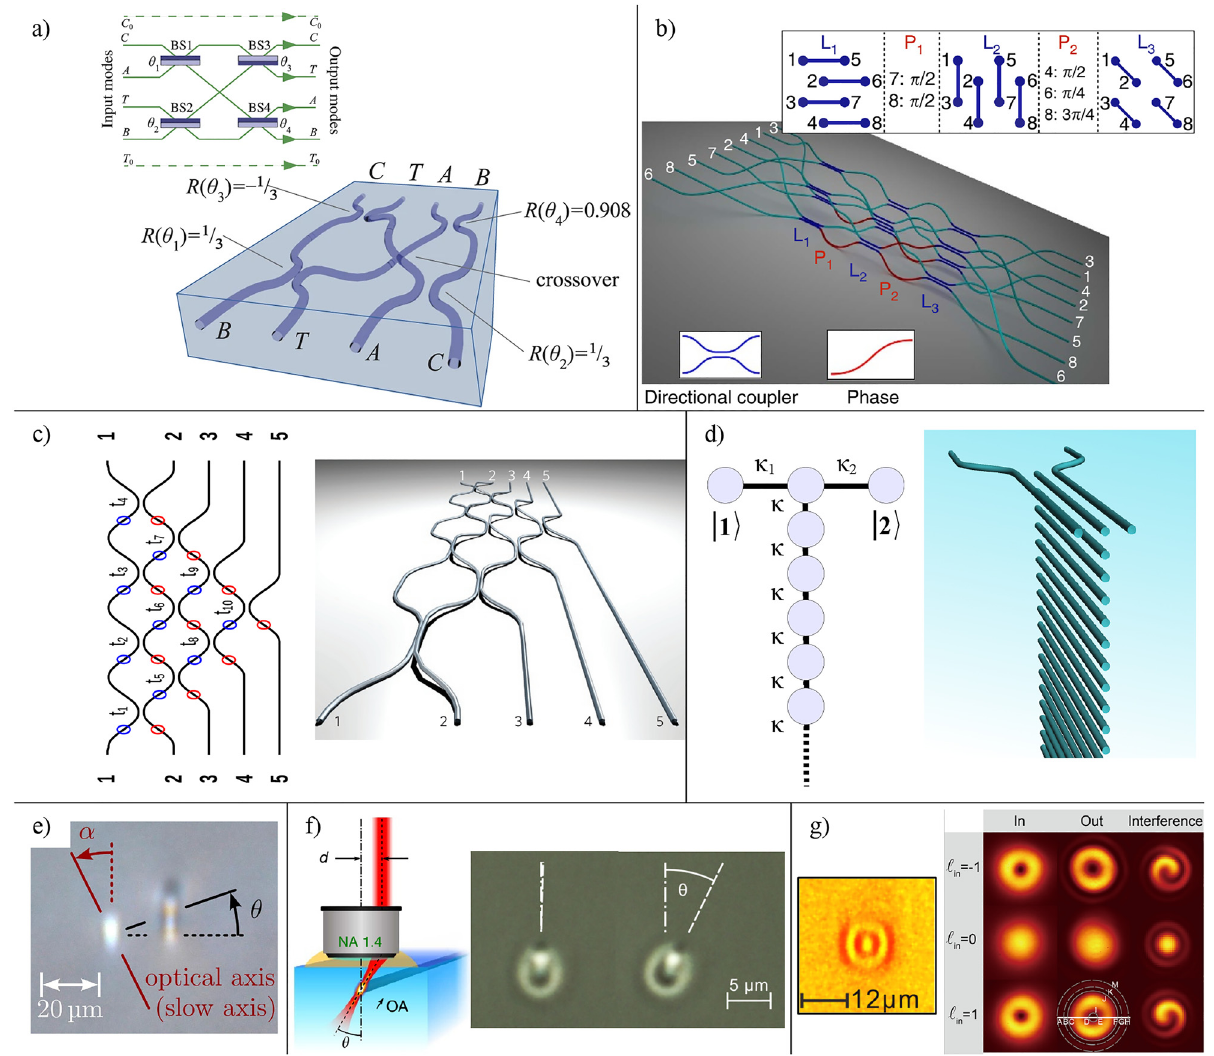
Figure 4: Examples of static, femtosecond-laser-written photonic circuits adopted for quantum applications. (a) Heralded controlled-Z gate for path-encoded photonic qubits: the bulk-components schematic is depicted on the top-left; on the right a pictorial representation of the femtosecond-laser written circuit. The optical waveguides pass one over the other without crossing, at the center of the circuit. (b) Three-dimensional circuit implementing the quantum Fourier transform of eight optical modes. The circuit is composed of three sections and ) are shown in the inset. The implemented phase shifts in each step ( P ) are also indicated. (c) couplings between modes in each step ( L i i Conceptual scheme and three-dimensional representation of a 5-mode circuit, realized according to the Reck’s layout, which implements an arbitrary unitary transformation between the input and output modes. (d) Example of a circuit for analogical quantum simulation: the quantum system represented on the left, consisting of two discrete sites ( | 1 ⟩ and | 2 ⟩ ) coupled to a linear chain of sites, can be simulated by the photonic circuit depicted on the right. (e) Cross-section of an integrated waveplate (microscope picture): the birefringence axis of the waveguide (on the left) can be rotated by writing an additional track (on the right) which induces stress on the former. (f) An alternative approach to tilt the birefringence axis of a waveguide of an angle 𝜃 (see cross-sections on the right) is to employ, for the laser inscription, a large-numerical aperture objective: the writing laser beam, which must not fill the objective completely, impinges on the objective entrance at a distance d ∝ tan 𝜃 from the optical axis. (g) A ring-core waveguide is inscribed by juxtaposing irradiated tracks, to describe a circle. A of orbital angular momentum. straight waveguide segment with such shape is able to propagate optical modes with non-vanishing values l m Pictures in the panels have been adapted, respectively, from Refs. [ 98 , 102 , 106 – 110 ].